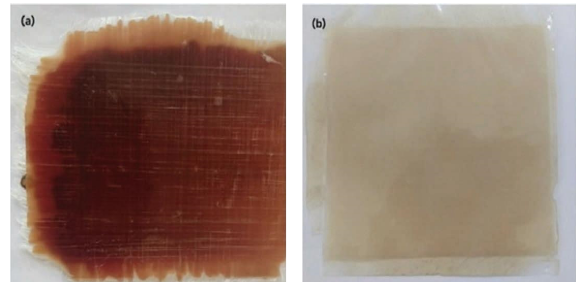
Figure 4: Composite samples prepared of triple layer oriented in biaxial direction: (a) silk fbres and (b) silk